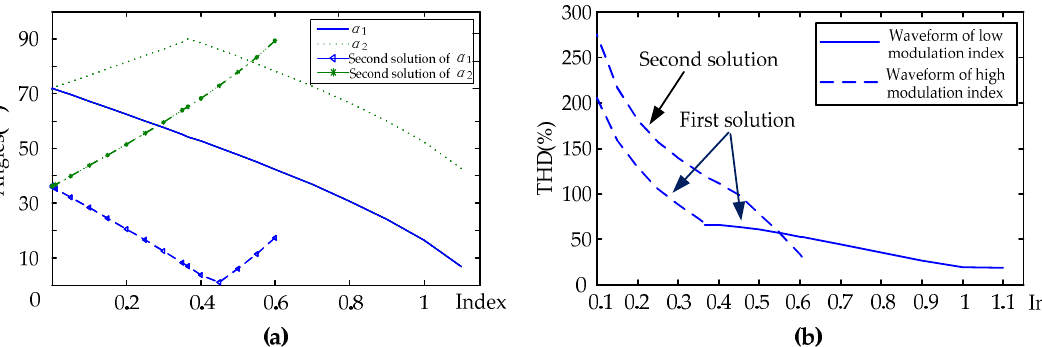
Figure 9. Trends of two switching angles and second solutions with the varying of the modulation index: ( a ) switching angles of the PSOICA; ( b ) THDs of the two different solutions.